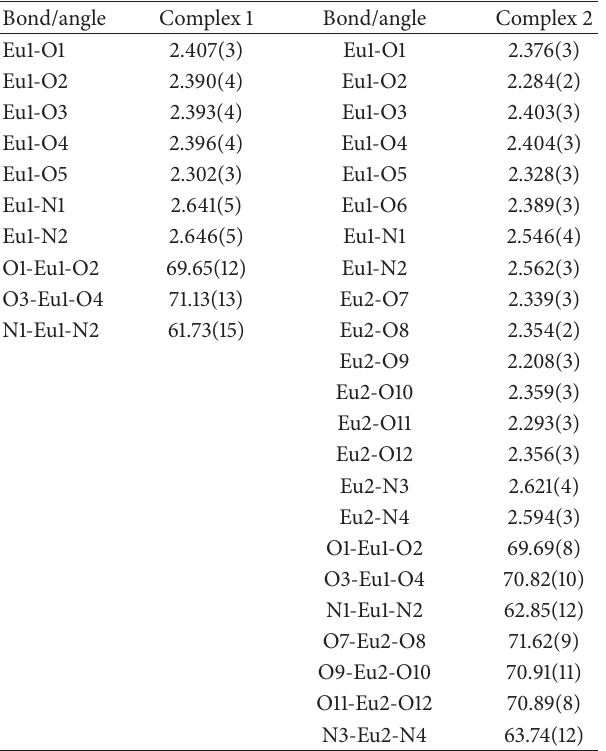
Table 2: Selected distances and angles (˚A, degrees) for the mononu- clear and the homodinuclear Eu 3+